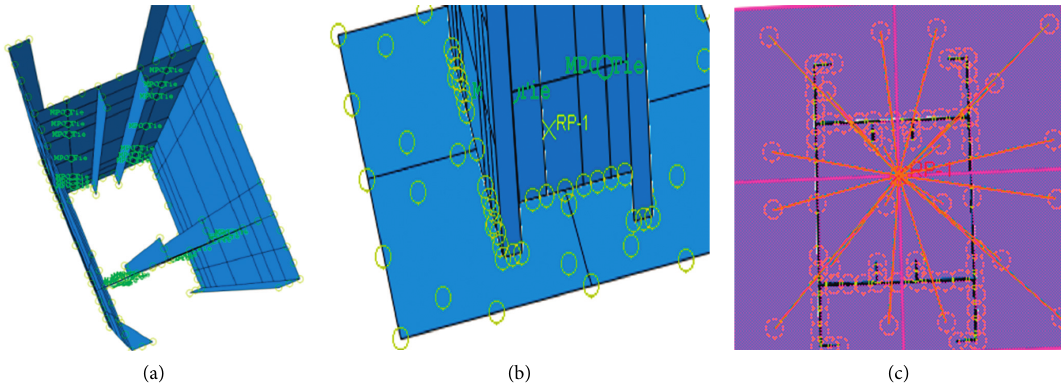
Figure 32: Interaction property settings: (a) screw simulation, (b) end binding constraints, and (c) end coupling.